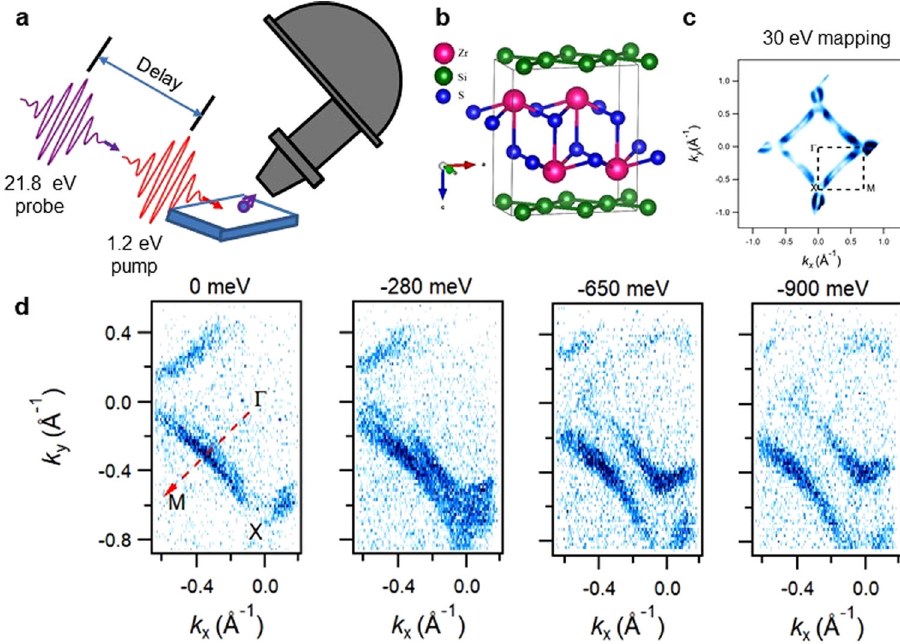
Fig. 1 Angle-resolved photoemission spectroscopy (ARPES) measurements of ZrSiS. a Schematic view of pump-probe ARPES set-up. The photon energies of the pump and probe pulse are 1.2 and 21.8 eV, respectively. b Tetragonal crystal structure of ZrSiS. c Measured Fermi surface map of ZrSiS using a photon energy of 30 eV. It consists of two diamond shaped pockets formed by the crossing of the bulk valence and conduction bands and an additional pocket at the X point formed by the surface state. d Fermi surface (leftmost panel) and constant energy contours at various binding energies as noted on top of the contours. The measurements in panel d were performed in our home-built static ARPES